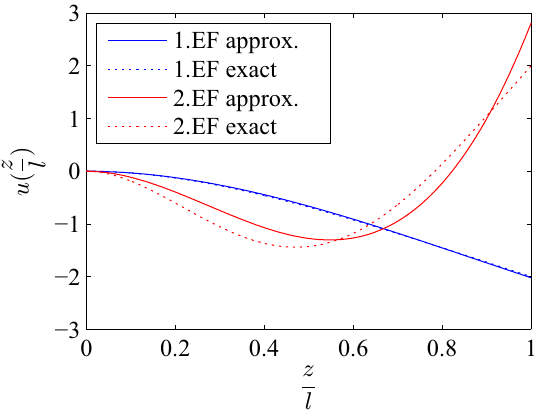
Figure 7. Comparison of the exact and approximated Eigenmodes of a semibeam